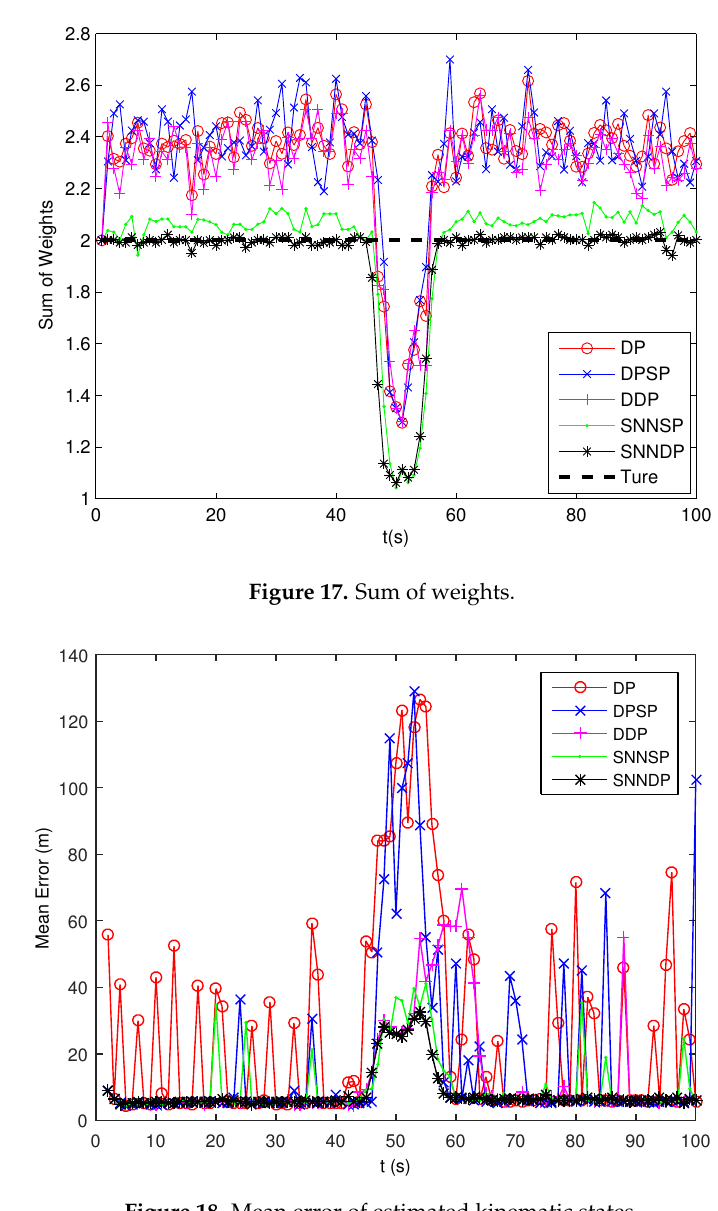
Figure 18. Mean error of estimated kinematic